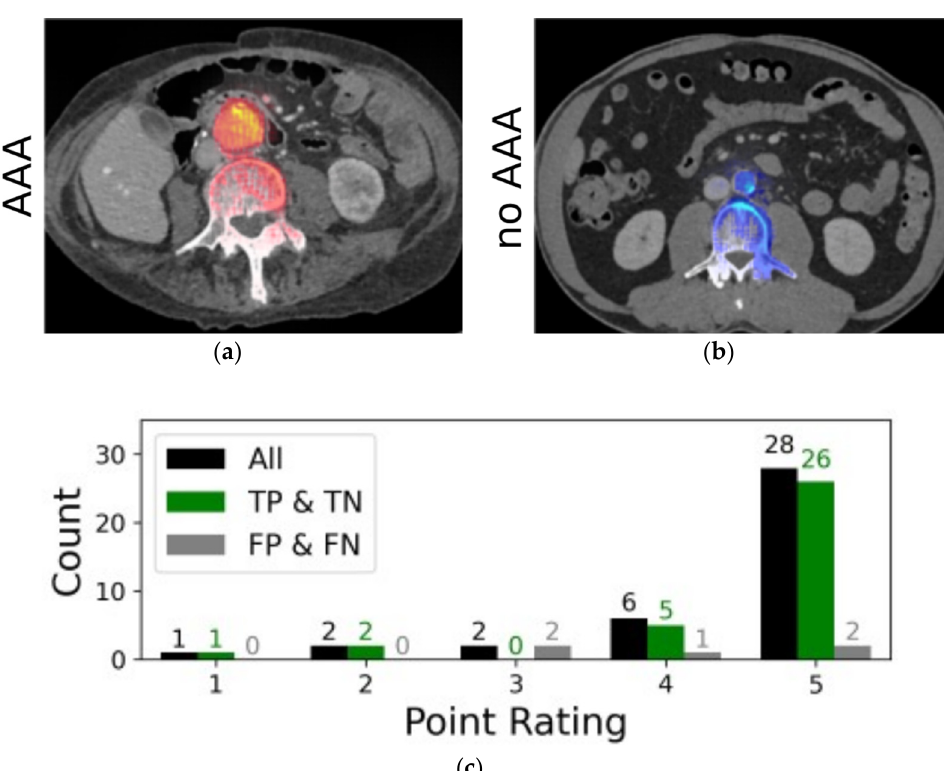
Figure 4. Experiment 2—results of the analysis using LRP. ( a , b ) show relevance maps for predicting the AAA super-imposed on the CT images for two example cases. ( a ) Shows a case with AAA, while ( b ) shows a case without AAA. Positive values are shown in red with high values in yellow, while negative values are shown in blue with high values as light blue. The high relevance around the aorta confirms that the networks correctly learned to make the classification decision based on the ROI. ( c ) Shows the score distribution of the assessment by an experienced radiologist.